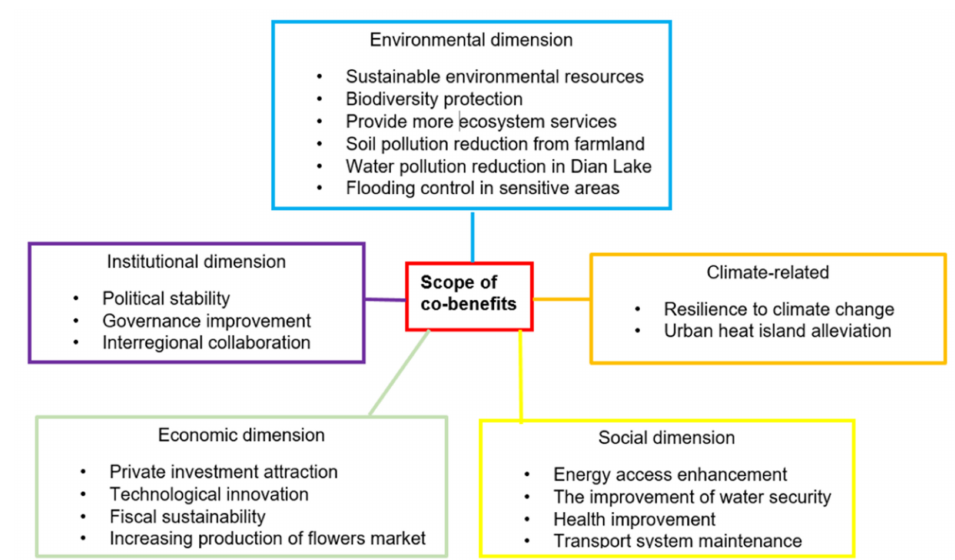
Figure 3. Co-benefits of water sensitive city